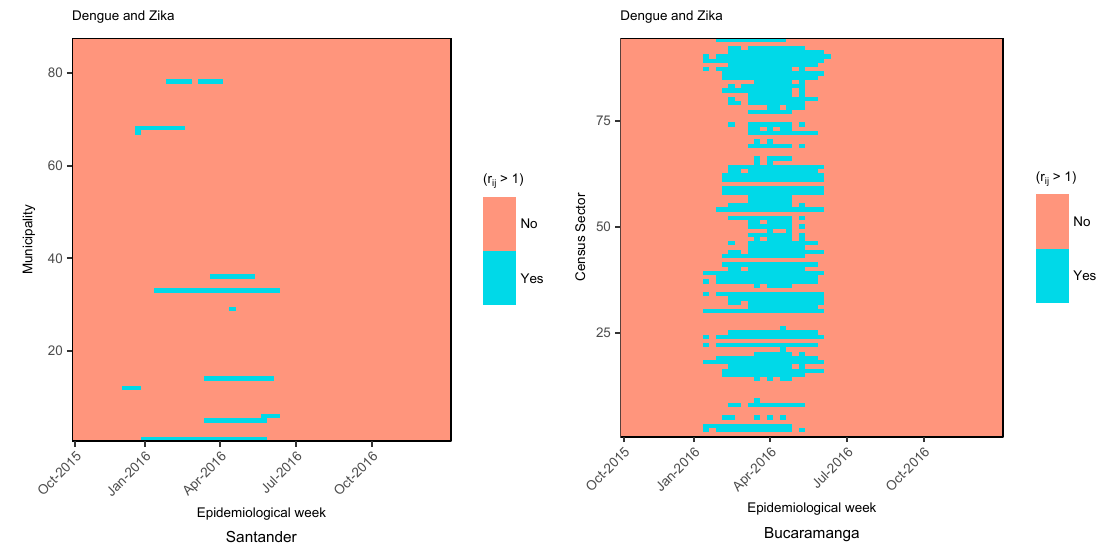
Figure 7. Heatmap of the relative risk greater than 1 ( r ij > 1) with 95% probability for dengue and Zika virus disease (ZVD) in the department of Santander and the city of Bucaramanga from October 2015 to December